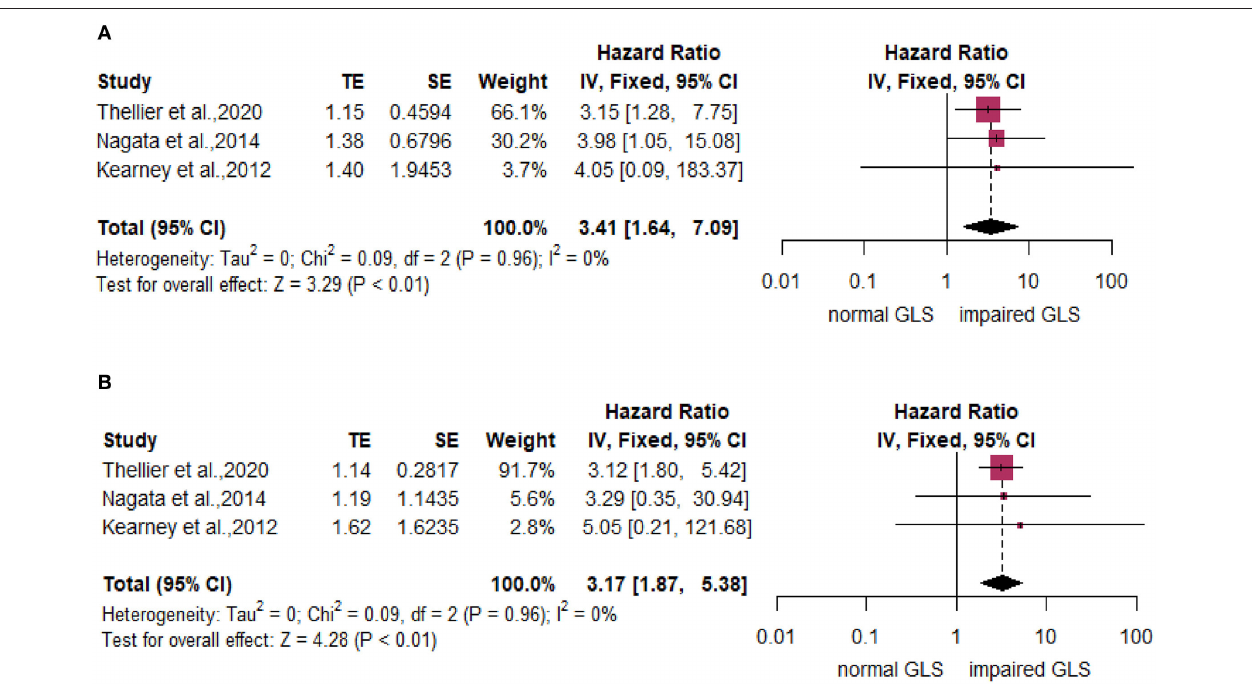
FIGURE 4 | Forest plot demonstrating the association between impaired GLS and MACE dichotomized by mean aortic valve pressure gradient (MG) over or below 40mm Hg. (A) MG ≥ 40 mmHg. (B) MG < 40 mmHg.